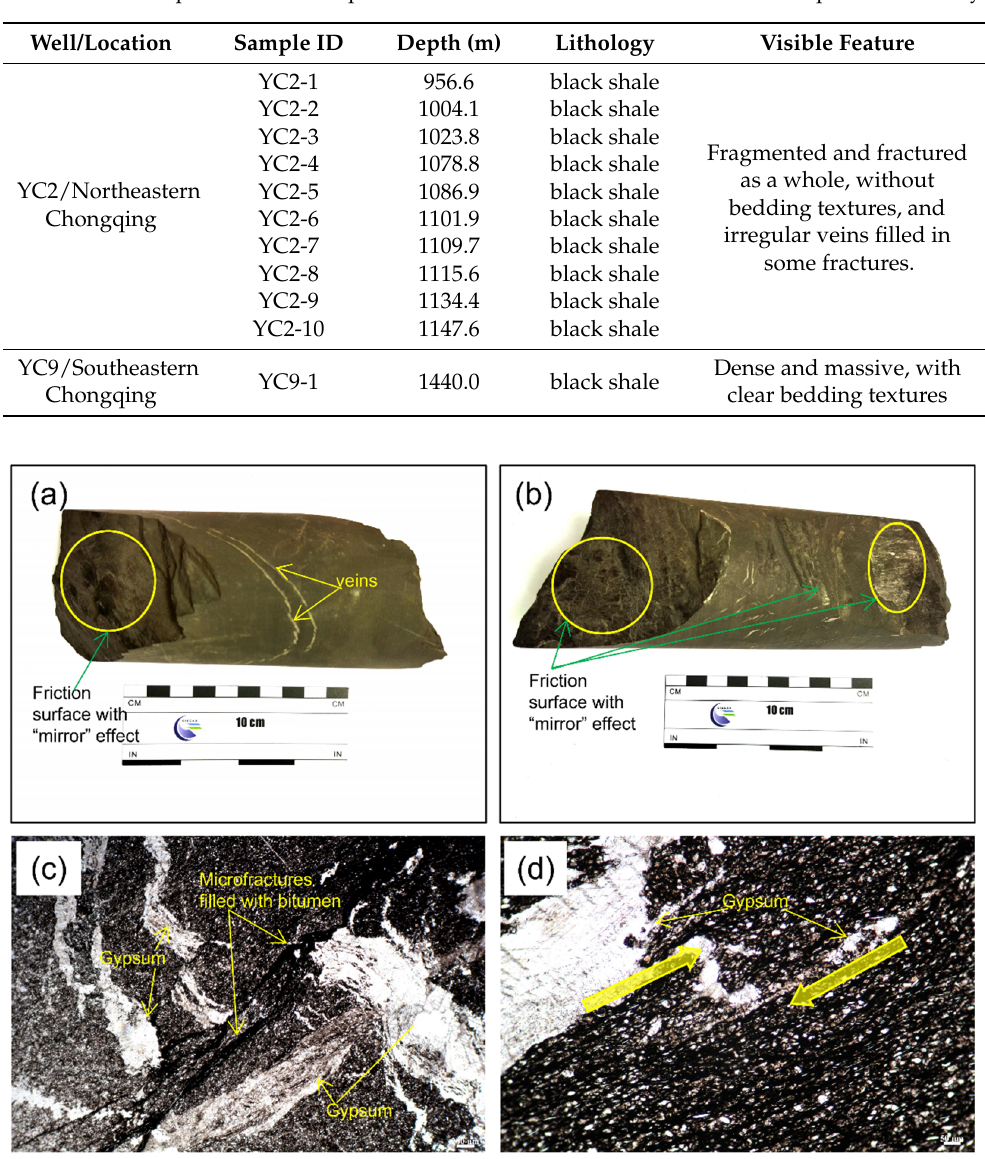
Table 1. Burial depth and macroscopic characteristics of Lower Cambrian shale samples in this study.